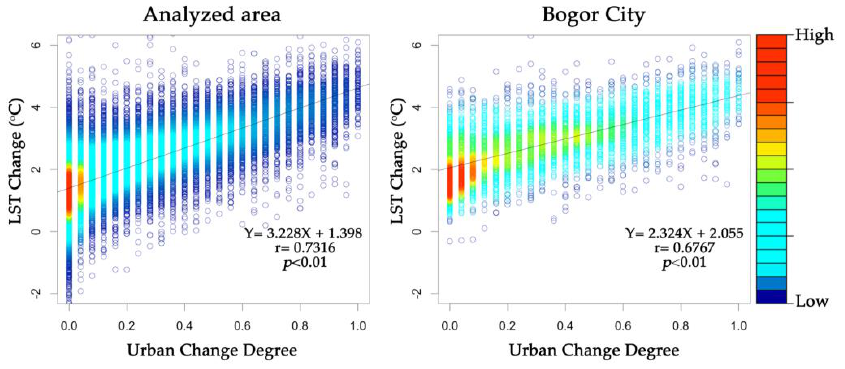
Figure 14. Relation of LST change and urban change degree in the analyzed area and Bogor City.